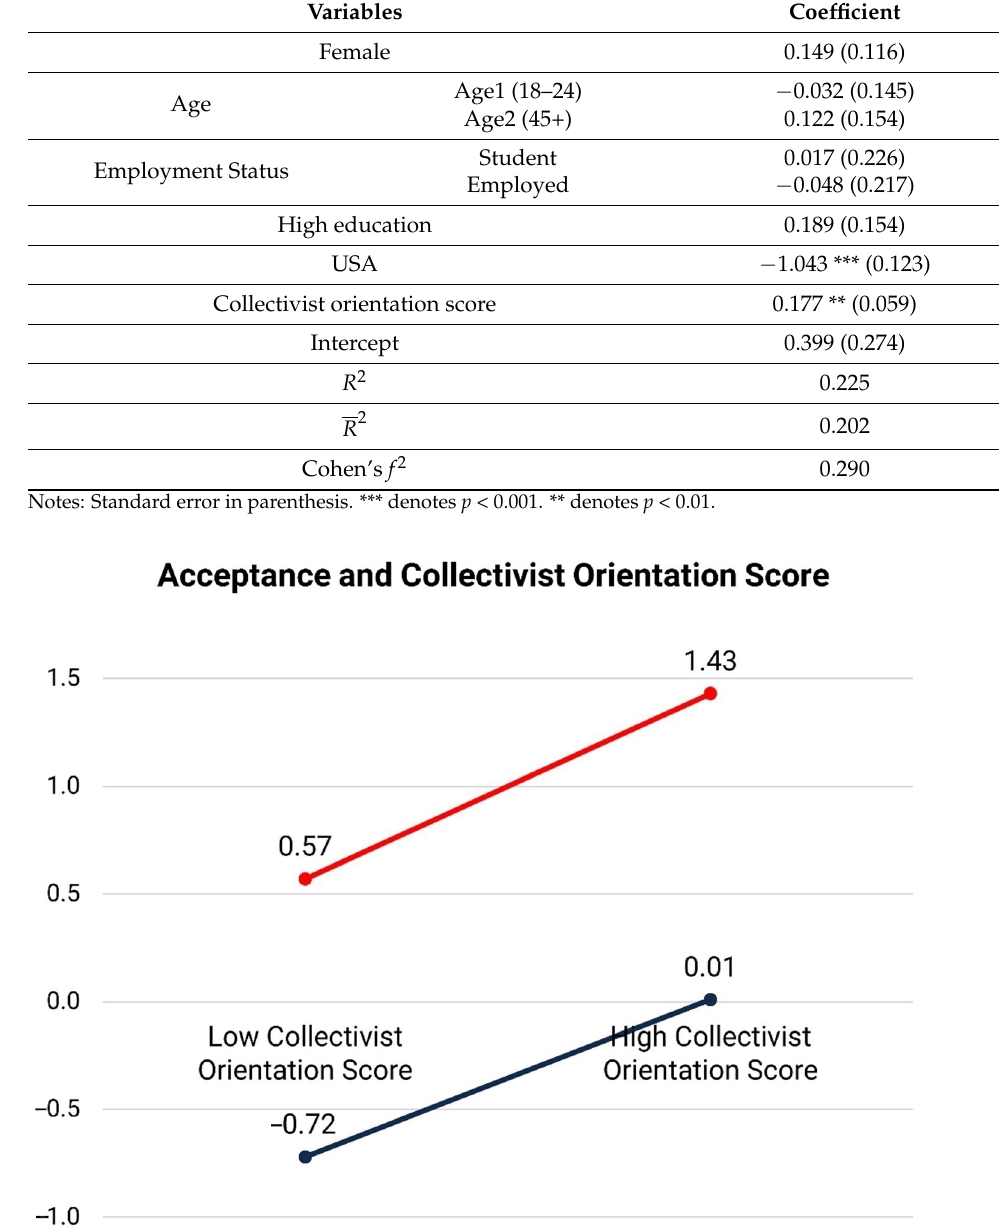
Table 12. Results of the linear regression model (Model 1) for the association between individual combined acceptance score and sociodemographic characteristics ( n = 277).